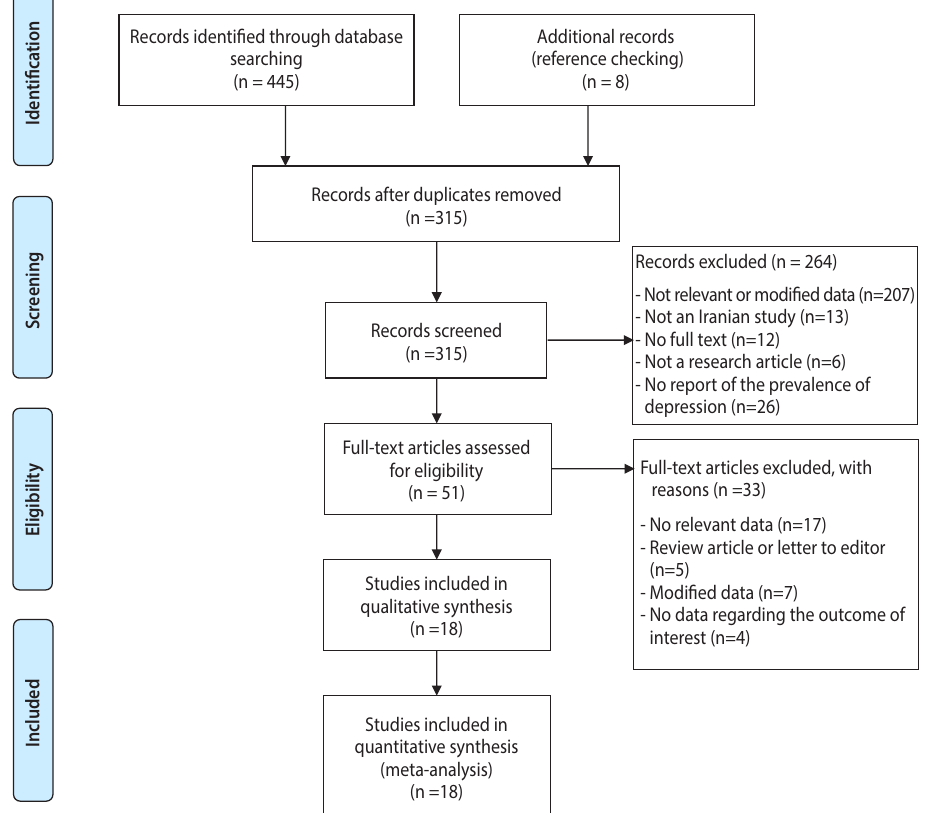
Figure 1. Flowchart of study inclusion and exclusion according to the PRISMA (Preferred Reporting Items for Systematic Reviews and Meta- Analyses)